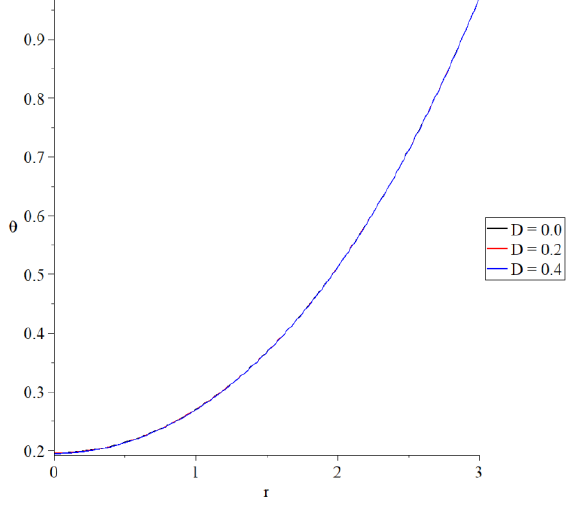
Figure 8. The distribution the dynamic temperature increment for the variance values of damage mechanics in the context of the hyperbolic two-temperature model.